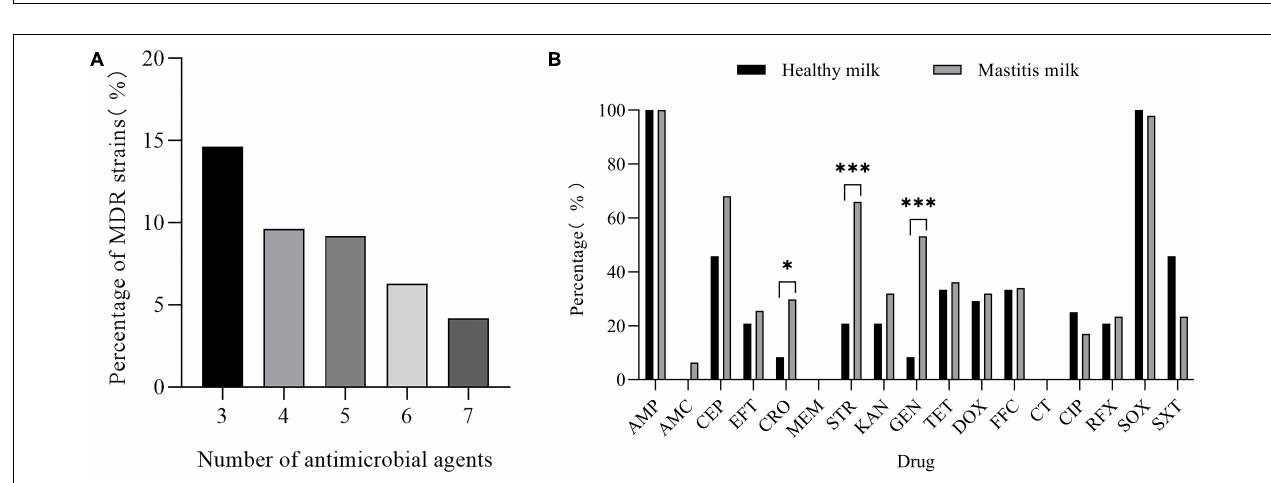
FIGURE 5 | Resistance rate of K. pneumoniae to 17 antimicrobials.